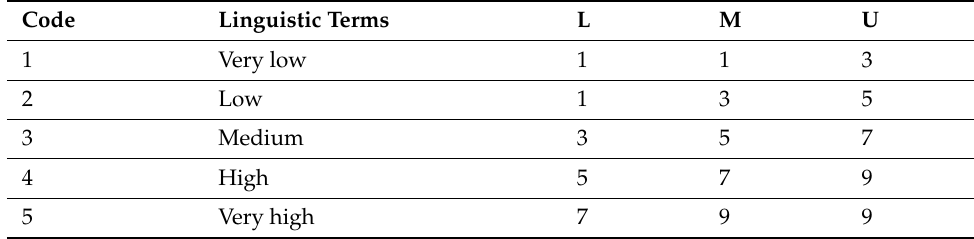
Table 2. Fuzzy Scale.